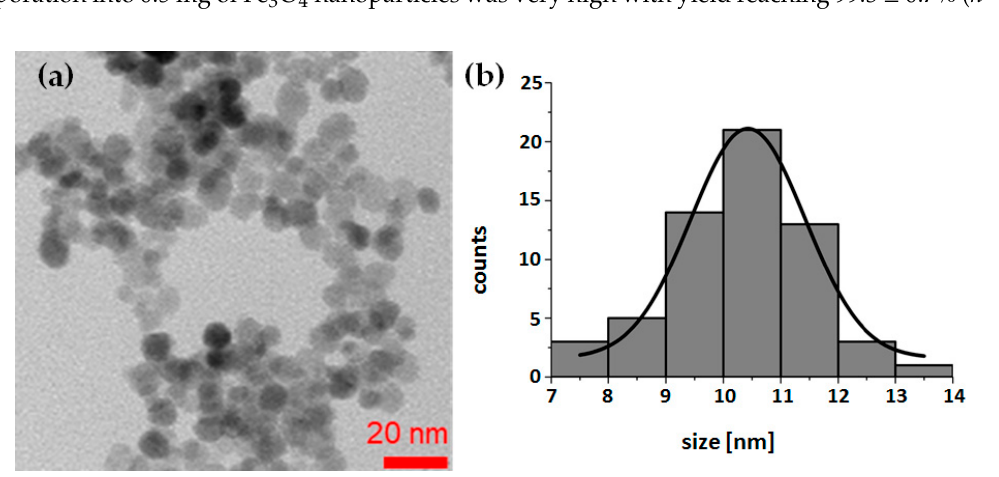
Figure 1. Representative transmission electron microscopy (TEM) image of synthesized Fe 3 O 4 nanoparticles ( A ), and a histogram of nanoparticles sized from TEM image ( B ).